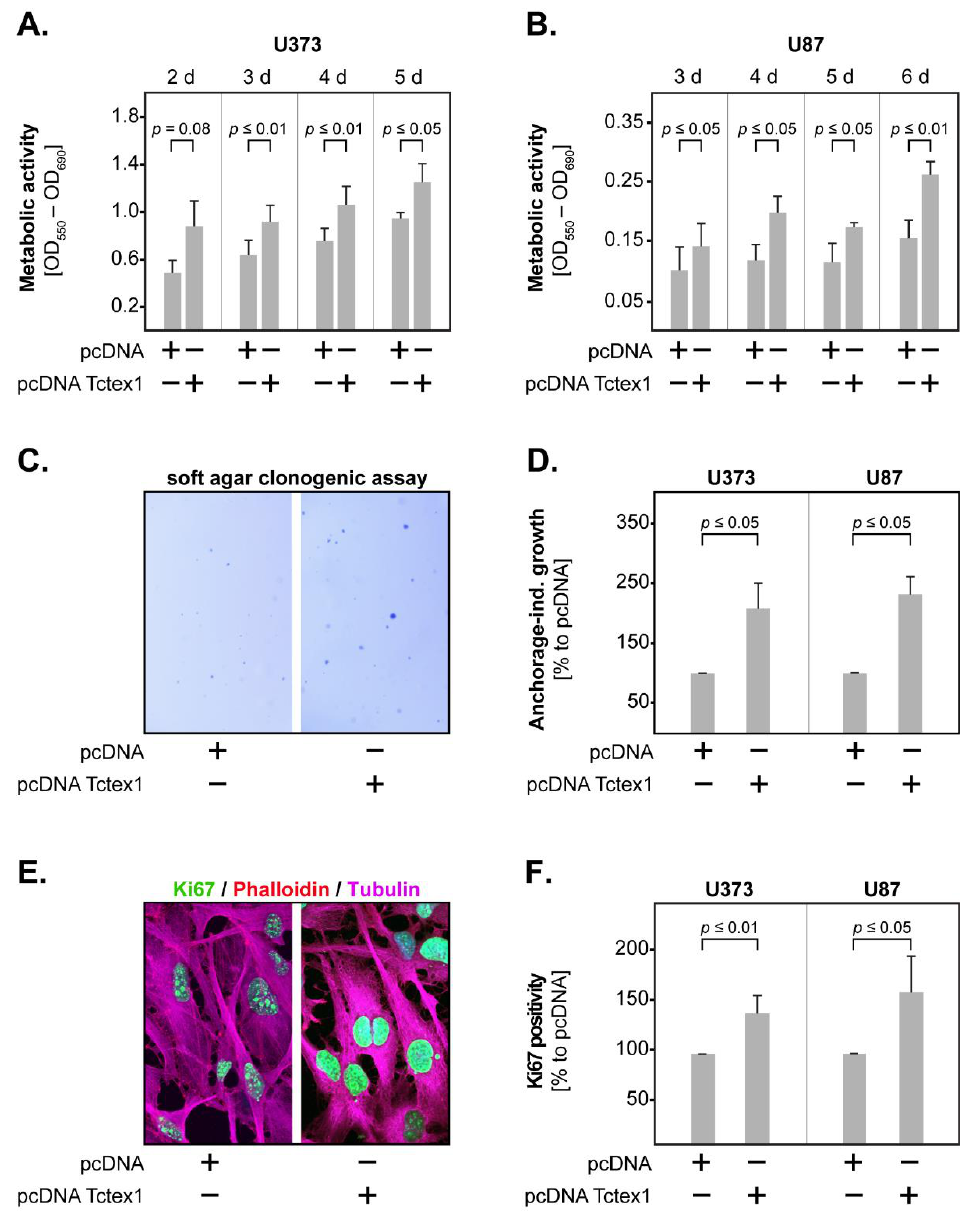
Figure 4. Tctex1 and GBM proliferation. Tctex1 overexpression significantly increased the metabolic activity of ( A ) U373 and ( B ) U87 GBM cells, as indicated by the MTT assay. ( C ) Representative micrographs of colonies generated by pcDNA and pcDNA Tctex1 U373 cells after 15 days of culture in low-gelling agarose. ( D ) Tctex1 overexpression significantly increased the anchorage-independent growth of U373 and U87 GBM cells. ( E ) Representative micrographs showing Ki67 staining (green) in pcDNA and pcDNA Tctex1 U373 cells. The cells were co-stained with phalloidin (red) and tubulin (magenta). ( F ) Tctex1 overexpression significantly increased Ki67 positivity in U373 and U87 GBM cells. At least 3 independent experiments were performed for each assay. In all studies, statistical analysis was performed with the paired t-test.